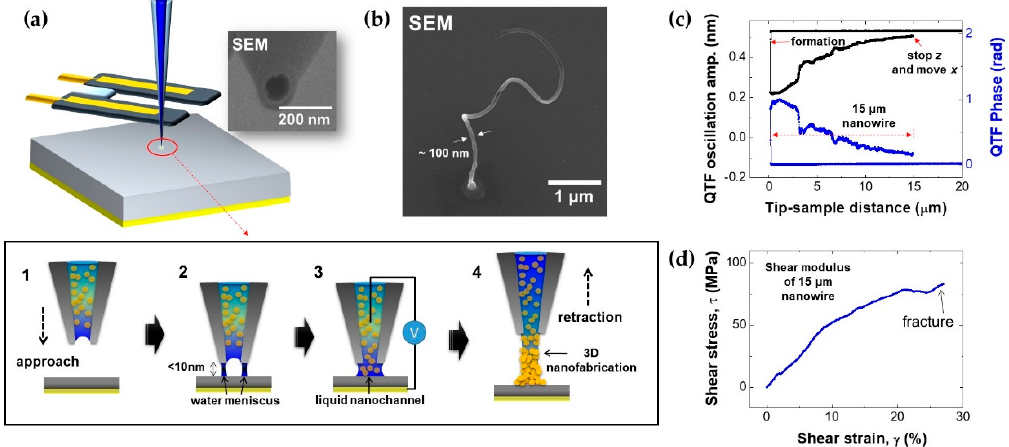
Figure 5. Nanofabrication via nanopipette/QTF–AFM. ( a ) Schematic and procedure of